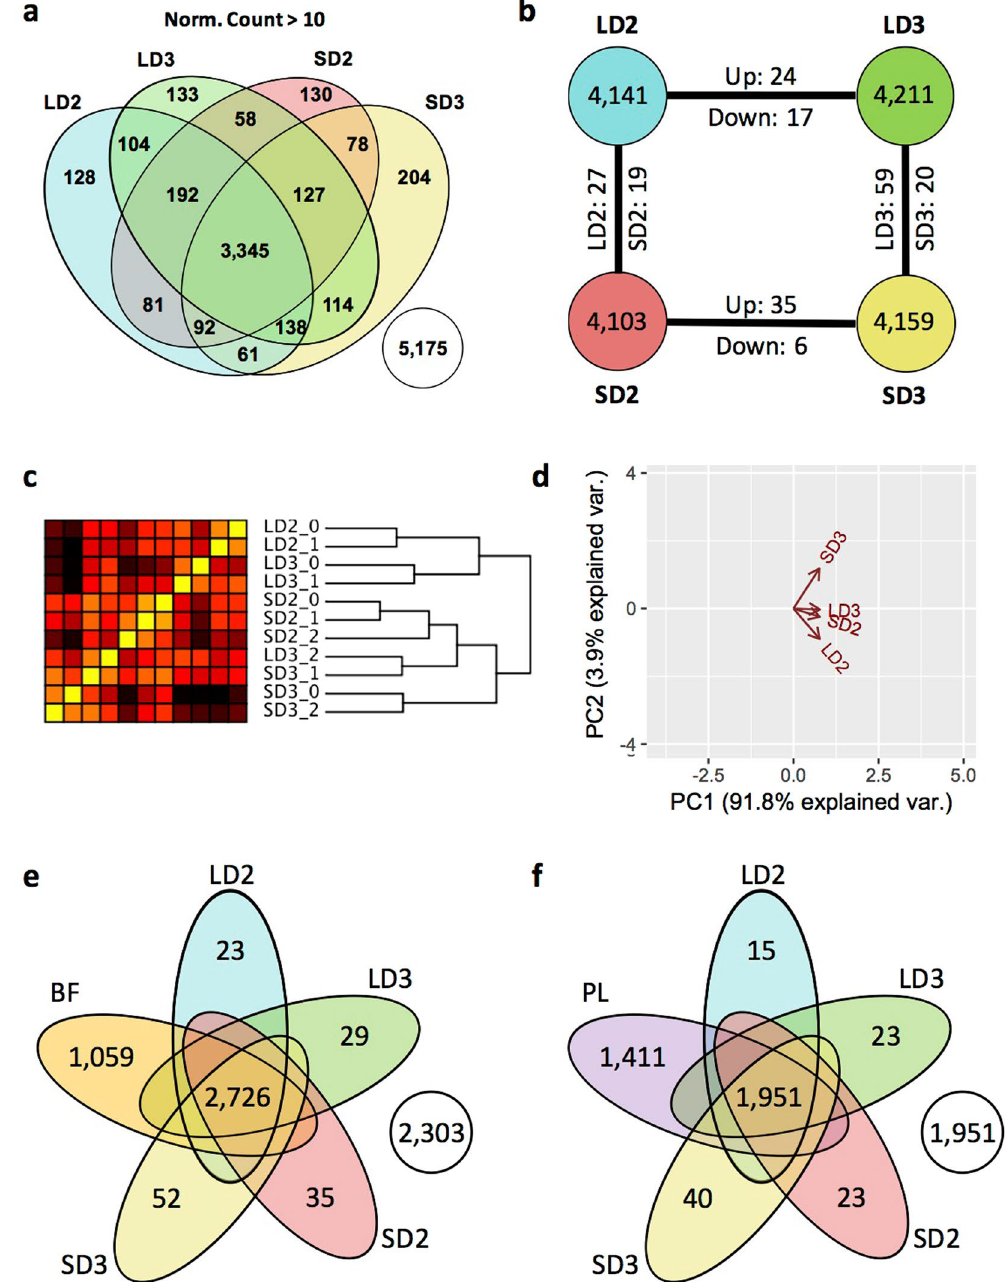
Figure 7. A. fumigatus transcript profiles during steroid and chemotherapeutic models of Invasive pulmonary aspergillosis day 2 and 3 post inoculation. Filtered, paired-end reads murine associated reads were analyzed by HTSeq. 2/DeSeq. 2 pipeline. Transcripts with a normalized count greater than 10 were considered adequately expressed. ( a ) Venn diagram of A. fumigatus transcript expression between the two models. ( b ) Diagram of number of unique A. fumigatus transcripts expressed and number of identified transcripts considered differentially expressed between the two models. ( c ) Hierarchical clustering and ( d ) principal component analysis of samples based on filtered gene expression. Venn diagram of fungal gene expression incorporating gene expression data sets of ( e ) biofilm (BF) and ( f ) planktonic (PL) growth (RPKM > 10). Steroid Model, S; Chemotherapeutic Model, L; Day 2, D2; Day 3,